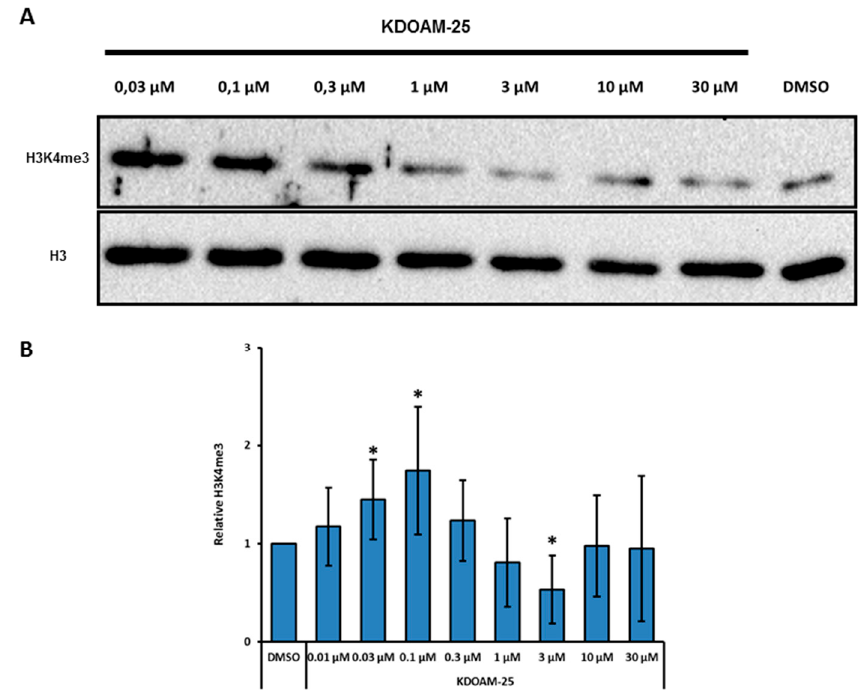
Figure 4. KDOAM-25 is a KDM5 enzymes inhibitor that increases H3K4me3 levels at lower concentration in MCF-7 cells. ( A ) Western blotting analysis of H3K4me3 levels in MCF-7 cells incubated for 24 hours with different concentrations of KDOAM-25. Shown image is representative of four independent experiments. ( B ) Quantification of western blot experiments, showing H3K4m3 levels upon KDOAM-25 treatment. Data are normalized to DMSO control and represented as the mean ± SD of relative H3K4me3 levels ( n = 4). Statistical significance was assessed according to two- tailed paired Student’s t test. * p < 0.05.